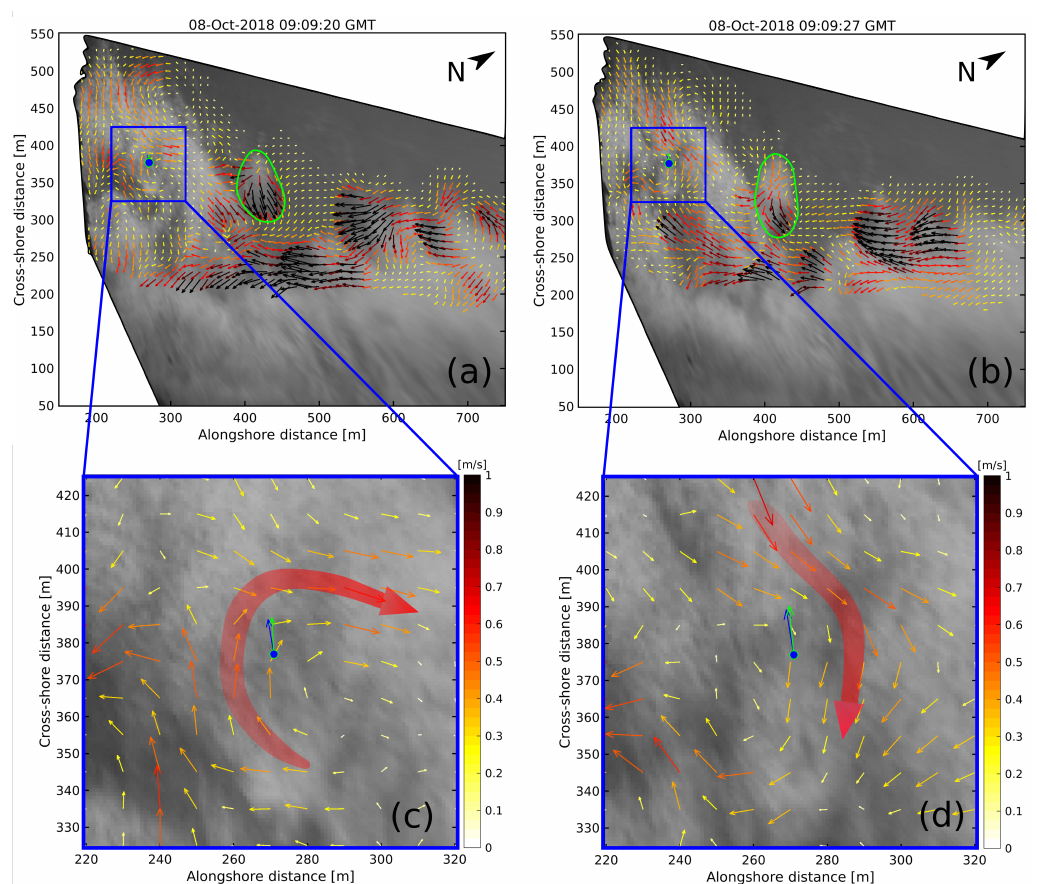
Figure 11. Influence of wave breaking on optical flow velocity estimates. Example of filtered breaking waves captured at instant ( a ) 8 October 2018-09:09:20 GMT and ( b ) 7 s after. ( c , d ) The same instants are shown for the image-region associated with the ADCP location depicted with blue color. Instantaneous OF ( f c = 1/20 Hz) velocity arrows are displayed every 10 m for better visualization. The blue and green arrows correspond to 20-s time-averaged ADCP surface and depth-averaged velocities, respectively. Optical flow and ADCP arrows are scaled the same. The thick red arrow represents the optical flow-derived dominant circulation for each instant. The green dashed line polygon illustrates an example of the creation of a foam blob advancing toward the shore induced by wave